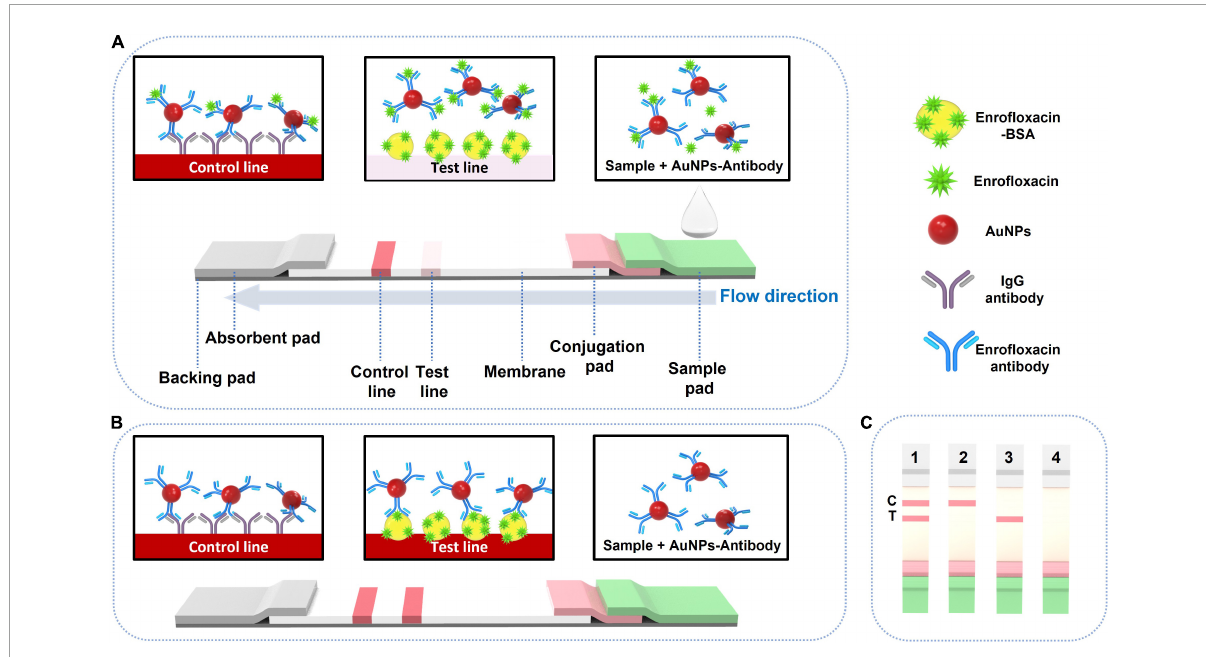
FIGURE1 Schematic illustration of LFIA test strip component and working mechanism. T: test line. C: control line. (A) Positive testing visual results, (B) negative testing visual results, and (C) negative visual results (1), positive visual results (2) and invalid results (3 and